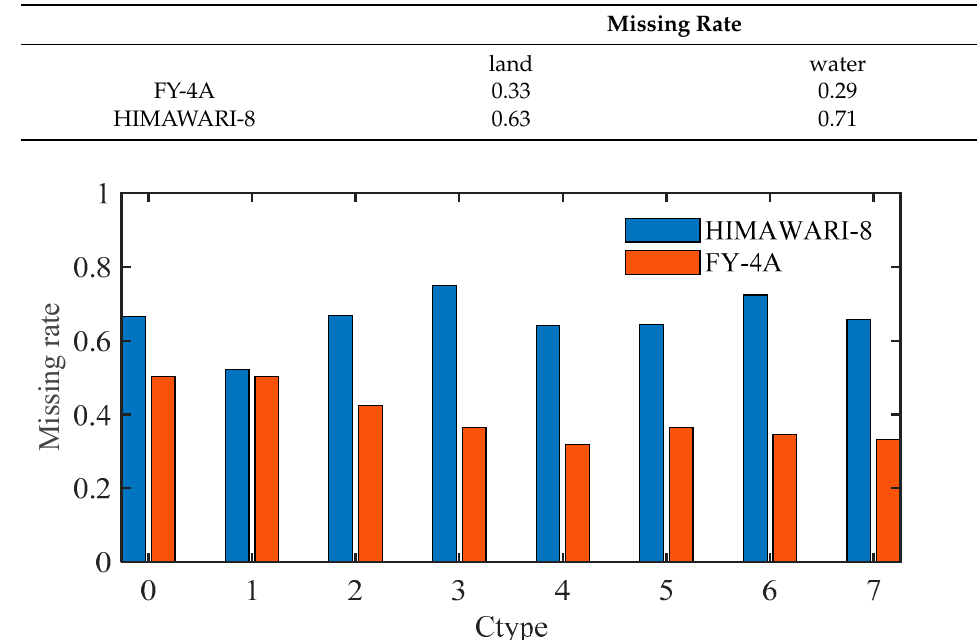
Figure 8. The frequency distribution of missing data of FY-4A and HIMAWARI-8 varies with CTH. ( a ) FY-4A and ( b ) HIMAWARI-8. Table 2. Missing rate of FY-4A and HIMAWARI-8 under different surface types.